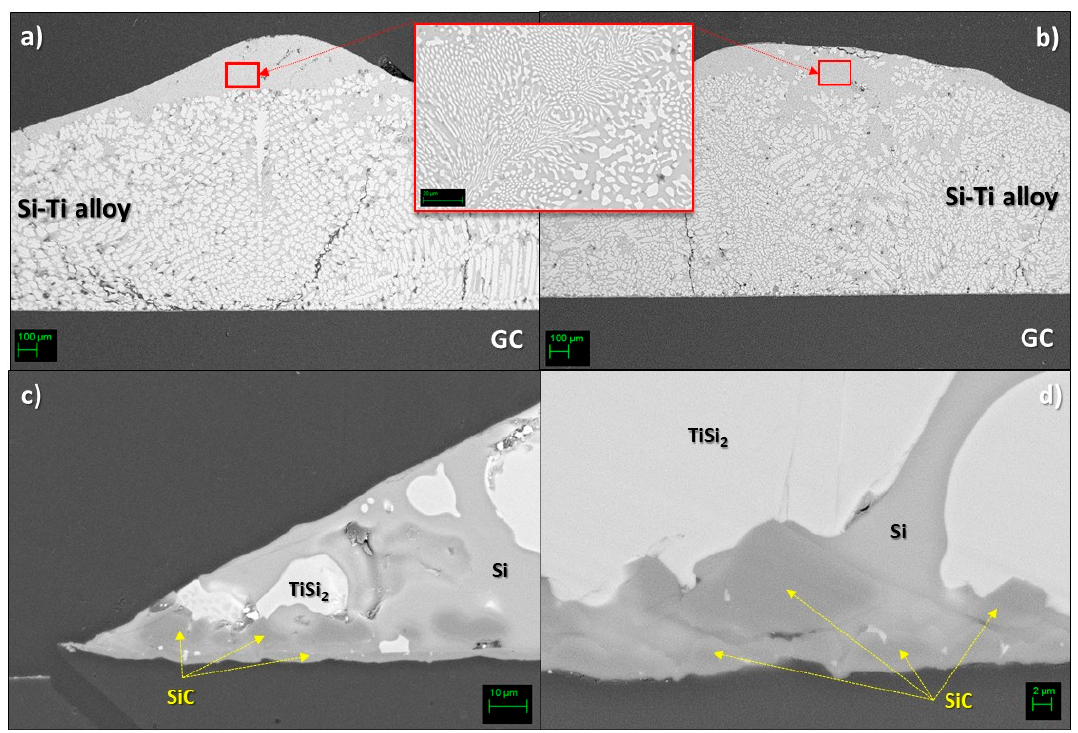
Figure 8. SEM-BSE images and phase identification by EDS analyses performed at different magnifications at the cross- sectioned Si-24at%Ti/GC samples processed by ( a ) classical sessile and ( b – d ) dispensed drop methods at T = 1450 °C under an Ar atmosphere.